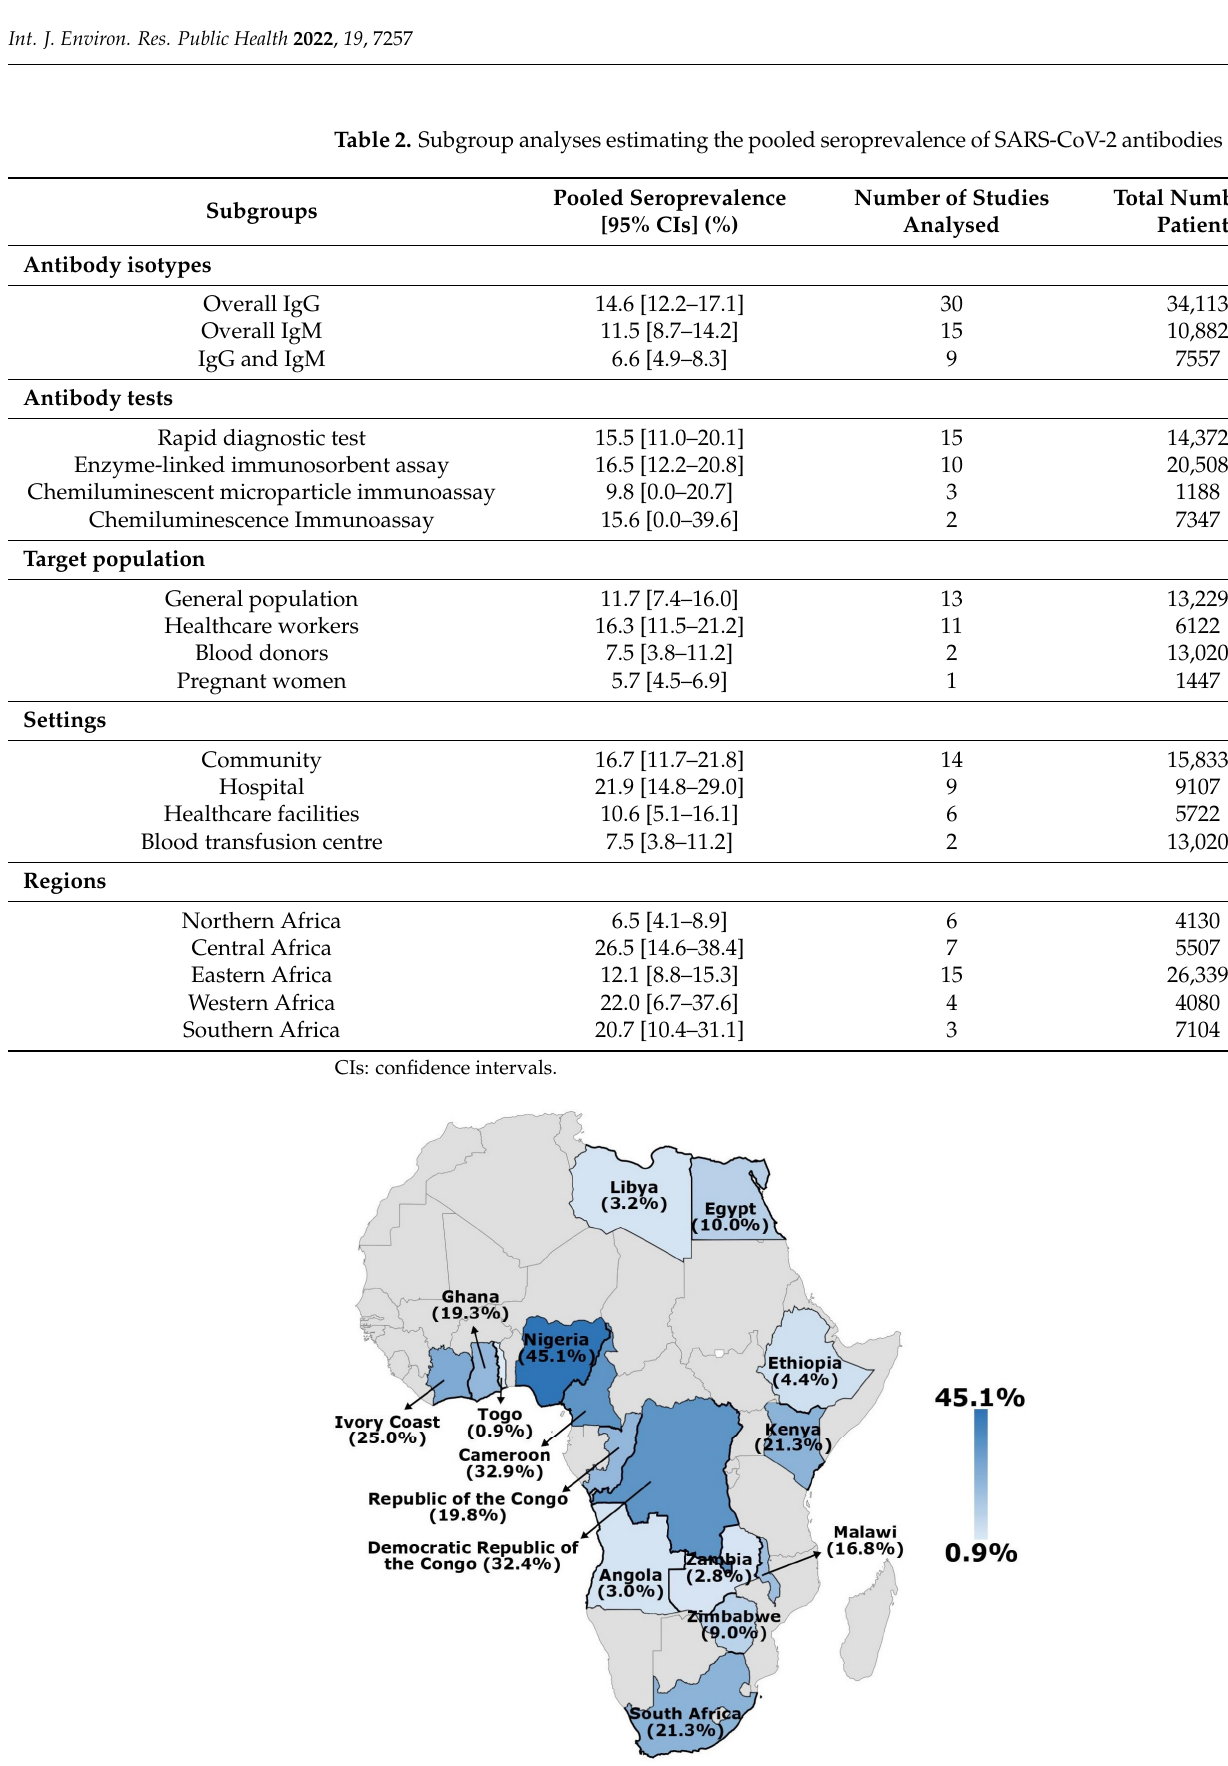
Figure 3. Overall seroprevalence of SARS-CoV-2 antibodies in different countries in Africa. The pooled estimates of SARS - CoV - 2 seroprevalence was highest amongst the par- ticipants recruited from hospitals (21.9%), followed by community (16.7%), healthcare fa- cilities (10.6%) and blood transfusion centres (7.5%). Based on the target group, HCWs were found to have a seroprevalence of 16.3%; the general population had 11.7% and blood donors and pregnant women had 7.5% and 5.7%, respectively. The seroprevalence of anti - SARS - CoV - 2 antibodies based on the geographical regions of Africa was 26.5% in Central Africa, 22.0% in Western Africa, 20.7% in Southern Africa, 12.1% in Eastern Africa and only 6.5% in Northern Africa.